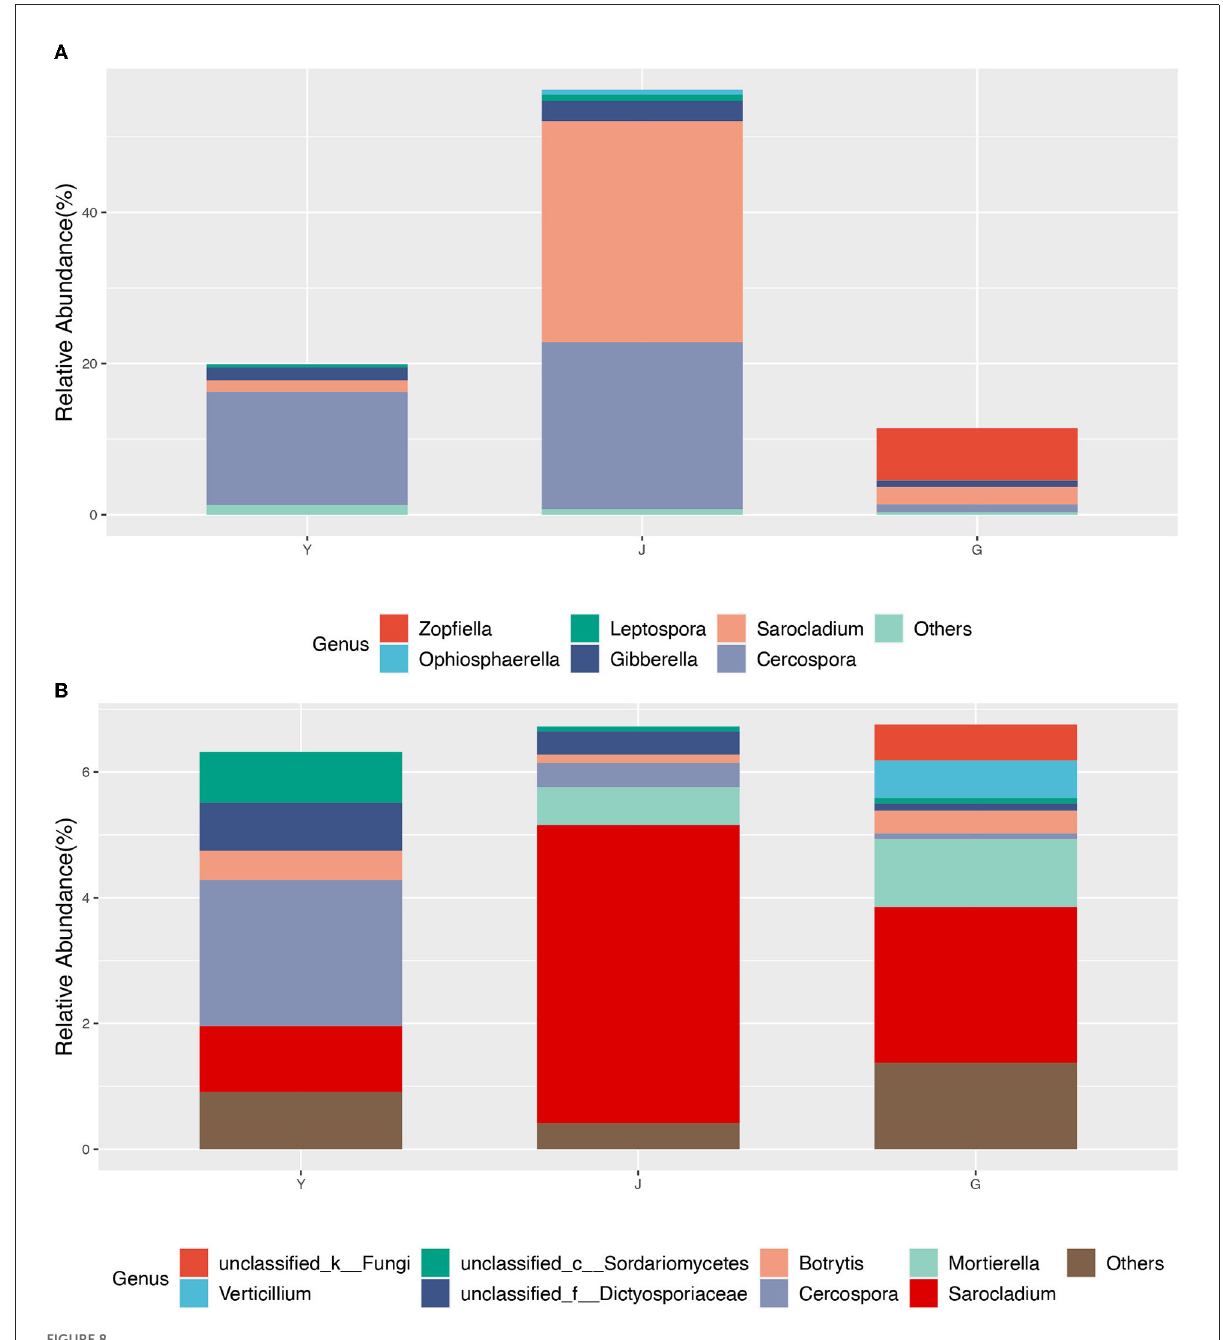
FIGURE8 The core community composition at the genus level. (A) ZP, (B)